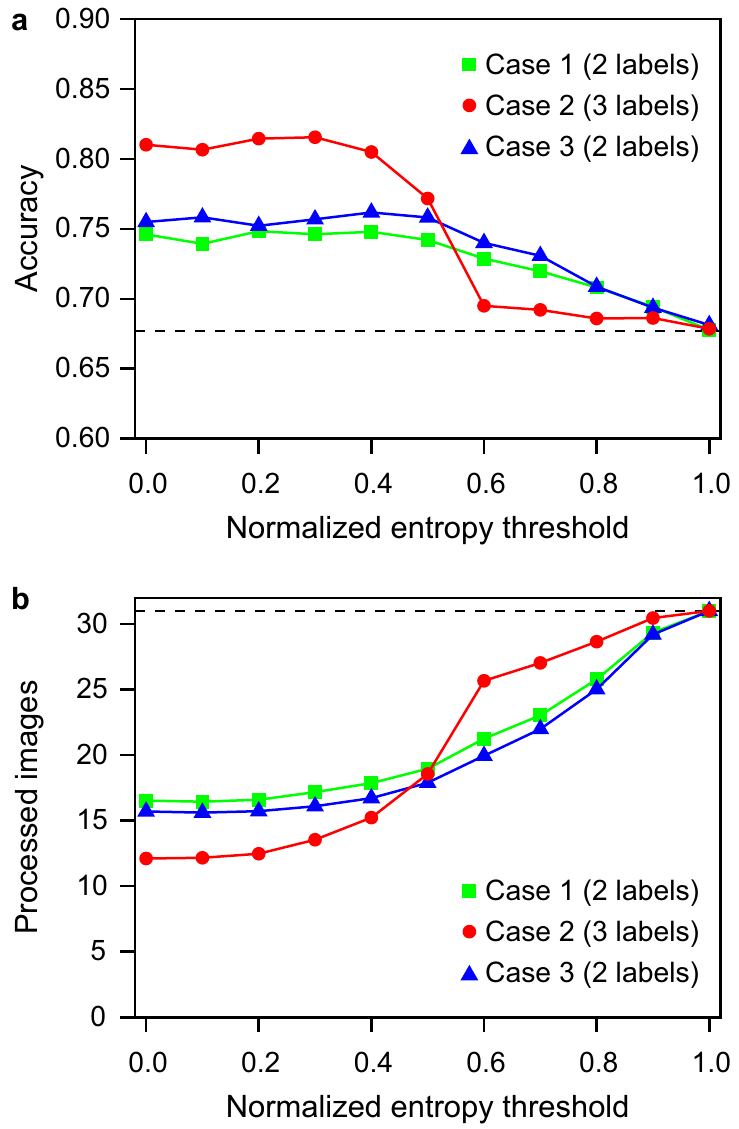
Fig 2. Performance of image classification as a function of the entropy threshold. (a) Accuracy and (b) number of image processed. Square: case 1, where image entropy is computed from two labels (“threat” and “no threat”), filled circle: case 2, where image entropy is computed from three labels (“threat”, “no threat”, and “I don’t know”), triangle: case 3, where image entropy is computed from two labels (“threat” and “no threat”) after reassigning “I don’t know” to either class proportional to “threat” and “no threat” by all participants. Points and vertical lines are means and standard errors of 1,000 runs. Dotted lines correspond to the case, where no entropy threshold was applied (that is, the image is retired from the repository when it receives three labels of “threat” and “no threat”